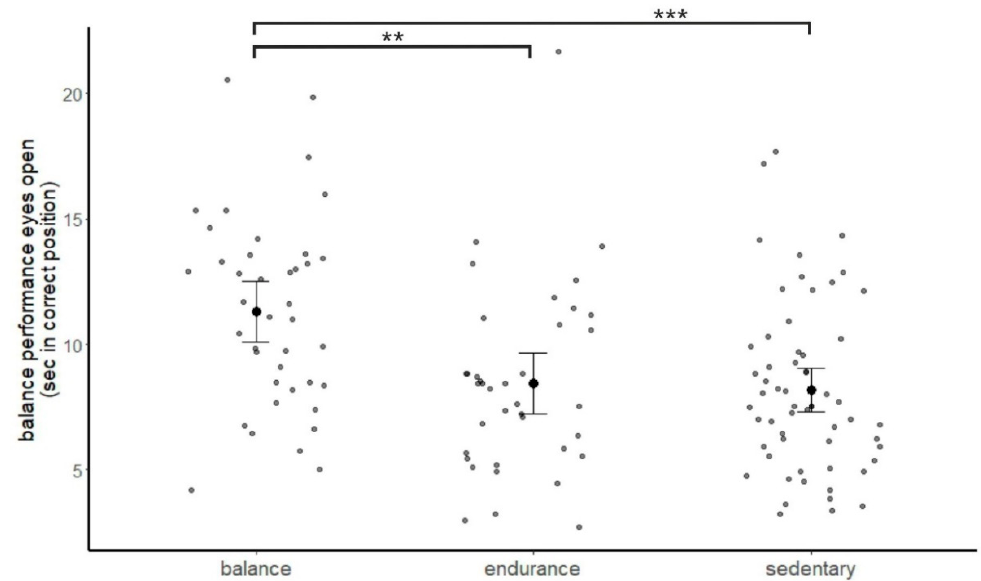
Figure 1. Mean performance on the balance platform in the eyes-open condition, separately for the balance experts, endurance athletes and sedentary participants. Error bars indicate 95% confidence intervals. Data of single participants are plotted in grey. ** p < 0.01, *** p < 0.001, post hoc contrasts. The pattern of results was confirmed when controlling for verbal IQ, F (2, 116) = 14.54, p < 0.001, η 2 = 0.200, balance vs. endurance: covariate-adjusted group difference = 2.70, p = 0.001, 95% CI (1.16, 4.24), balance vs. sedentary: covariate-adjusted group difference = 3.88, p < 0.001, 95% CI (2.44,